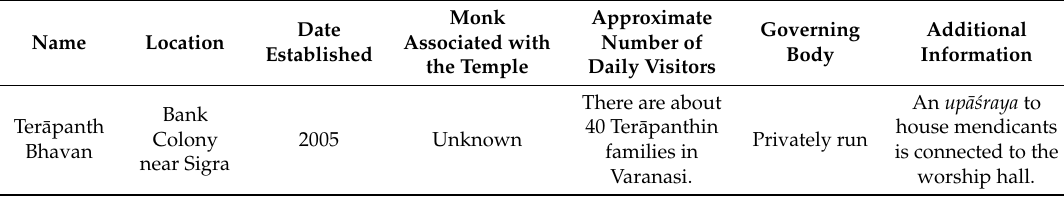
Table 3. Ś vet ā mbara temples in Varanasi.